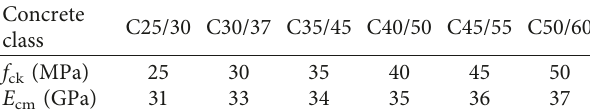
Table 4: Parameter study (concrete classes).